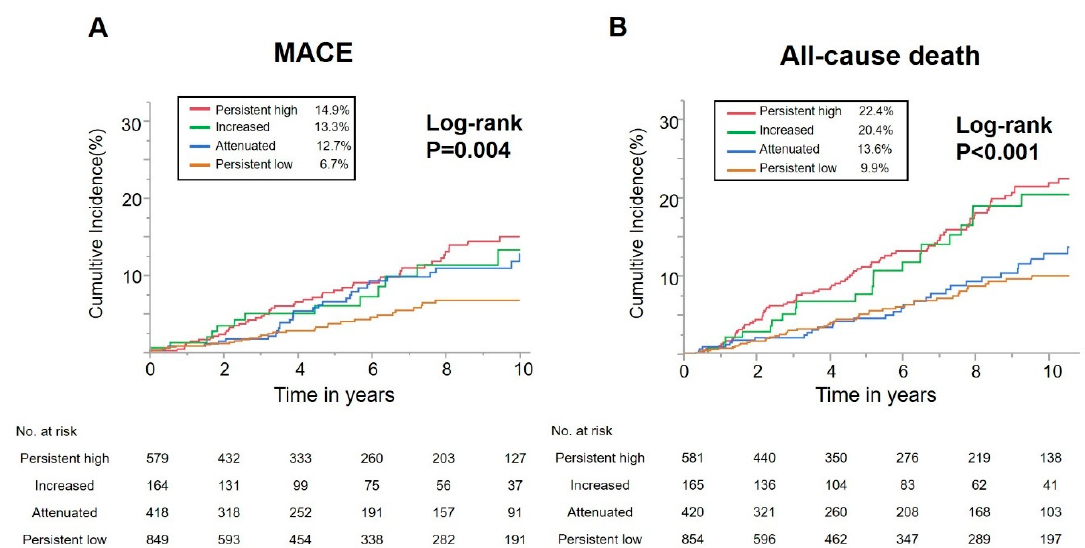
Figure 2. Kaplan–Meier curve for major adverse cardiovascular events (MACE) and all-cause death. ( A ) Long-term major adverse cardiovascular events (MACE) (composite endpoint defined as cardiovascular death, non-fatal myocardial infarction, or non-fatal cerebral infarction). ( B ) Long-term all-cause mortality.